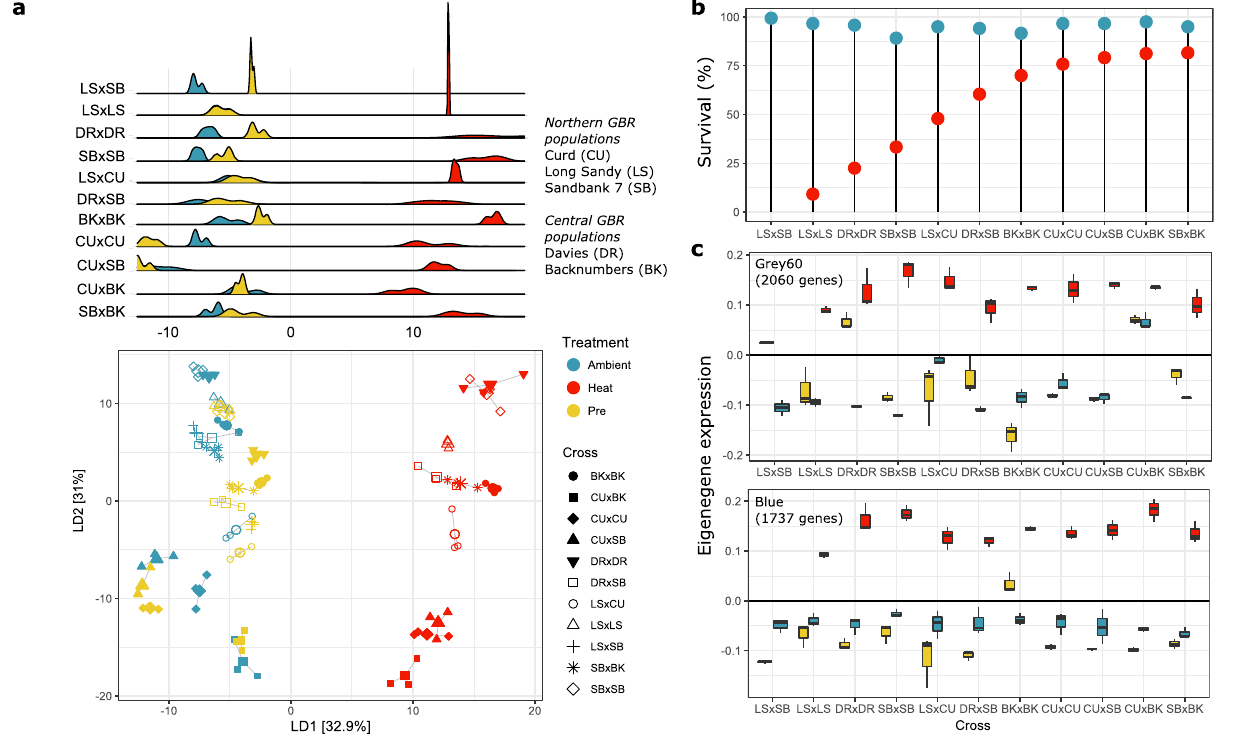
ranked from low to high survival in heat stress. b Larval survival in heat and ambient treatments. c Eigengene expression for two WGCNA modules posi- tively, and signi fi cantly correlated with larval response to heat. For each cross, the origin of dams is denoted fi rst, and the origin of sires is second ( n =3 pools of 10 larvae each per cross per treatment). Boxplots include the median values (center lines), upper and lower quartiles (box limits), 1.5× interquartile range (whiskers), and outliers